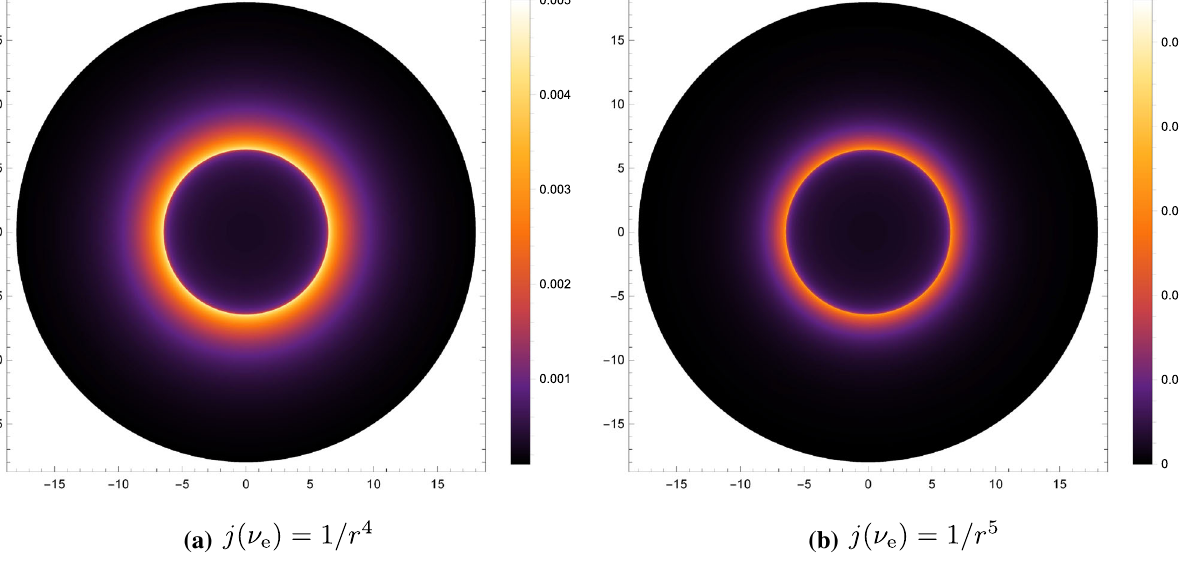
Fig. 8 Theshadowoftheblackholecastbytheinfallingaccretionwithdifferentprofilesofspecificemissivityinthe ( x , y ) plane.Weset α = − 5 . 5, M =